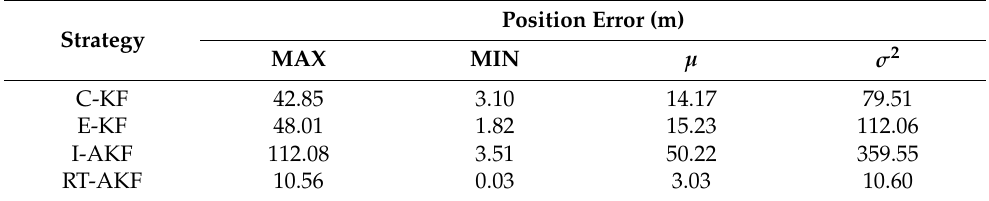
Table 4. Position Error Comparison Using Different Algorithm in Segment #2.